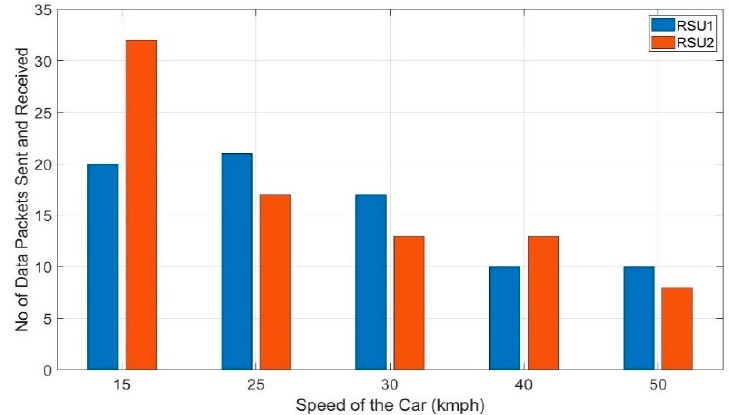
Figure 10. The number of data packets received by each RSU in preliminary testing without Kalman filter.